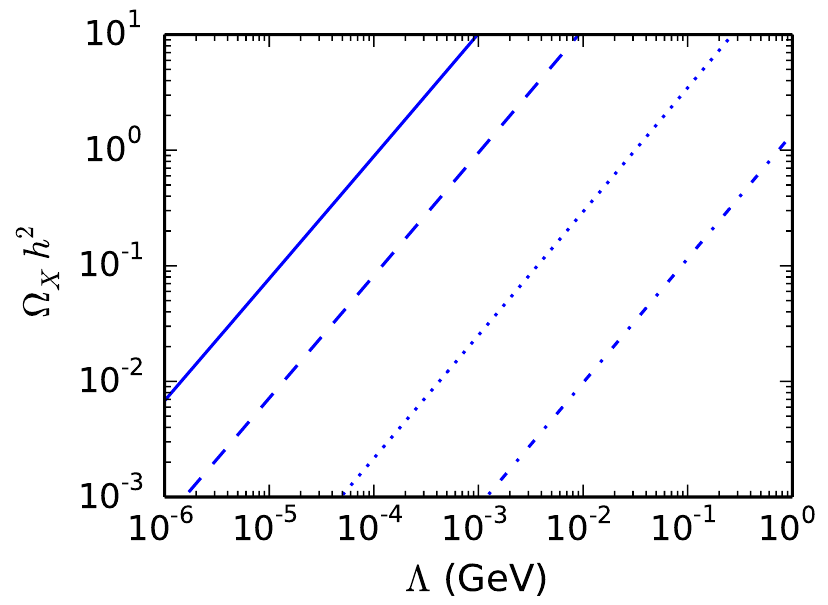
Figure 2 . The density parameter of the dark glueball, Ω X h 2 , as a function of Λ , taking m X = Λ and c = 1 . The non-minimal coupling of the Higgs boson is taken to be ξ 32 10 (dotted), and 100